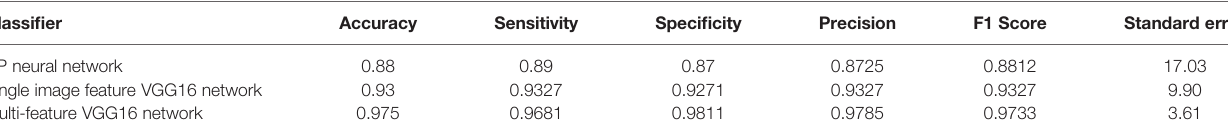
TABLE 6 | Comparison of nodular classi fi cation results by different